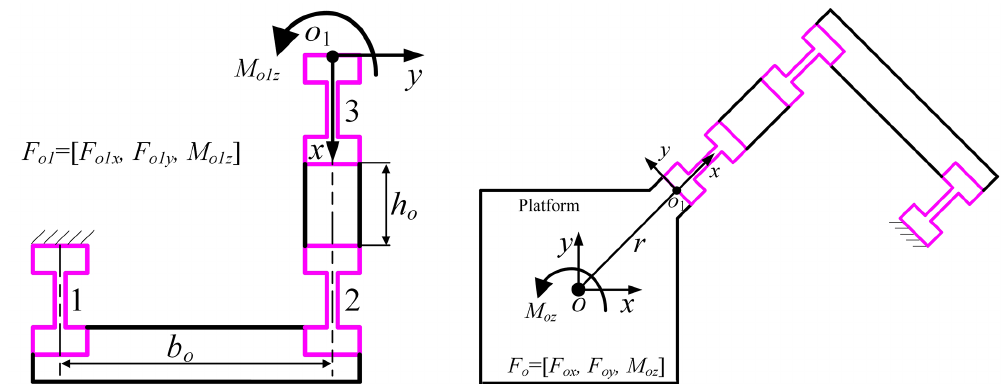
Figure 9. RRR flexure-based compliant mechanism: (a) applied forces/moments at output point o 1 ; (b) applied forces/moments at output point o .